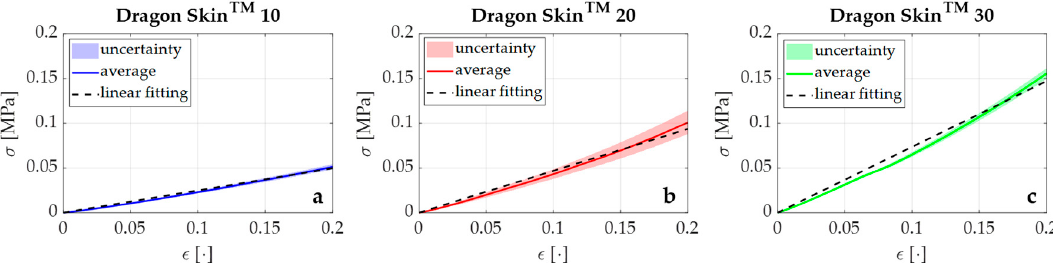
Figure 2. The σ – ε relationships for Dragon Skin™ 10, 20, and 30 are shown in blue ( a ), red ( b ), and green ( c ), respectively. In particular, the continuous lines represent the average σ exp values, the shaded areas the related uncertainties, and the black dotted lines the σ th values obtained by the best linear fitting model.